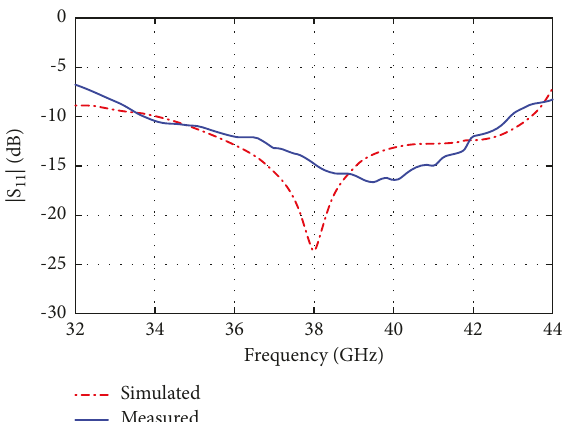
Figure 6: Simulated and measured reflection coefficient | S